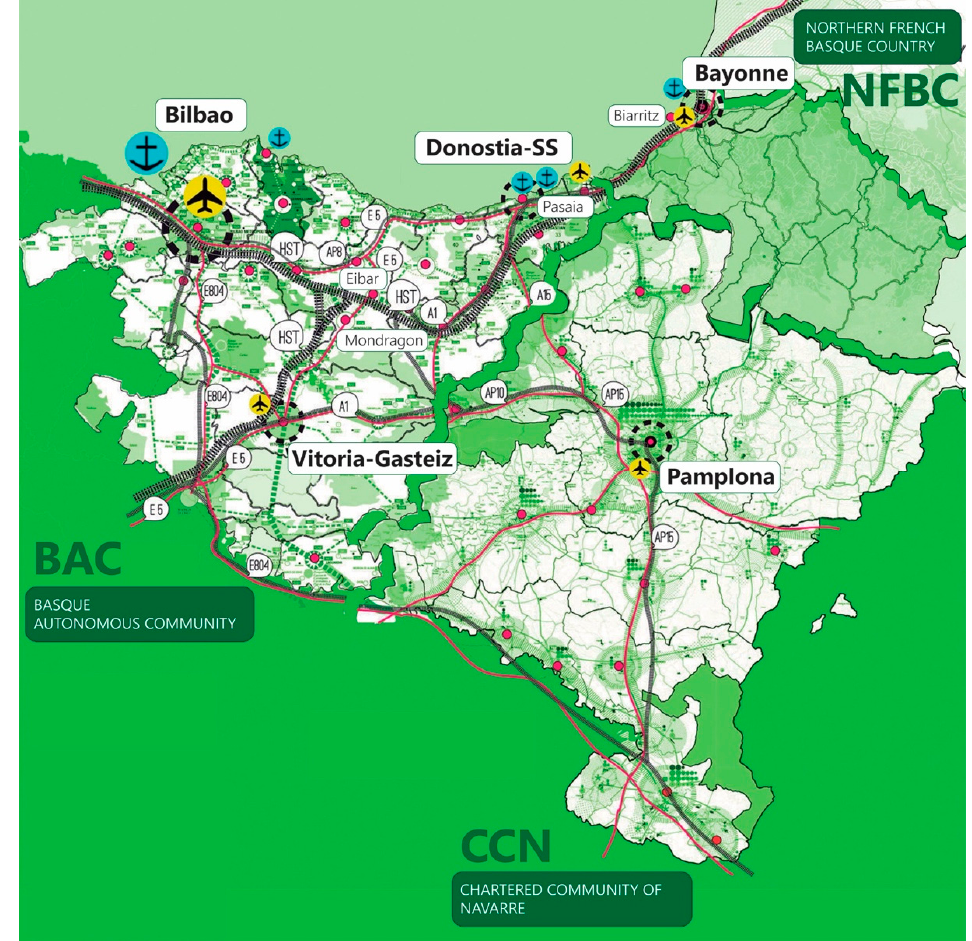
Figure 2. Continental Basque Country: Basque Autonomous Community (BAC) and Chartered Community of Navarre (CCN) in the Spanish Basque Country and Pays Basque commonwealth ( mancomunidad ) in the Northern French Basque Country (NFBC). (Source: Algorithmic Nations, Towards the Techno-Political Conceptual Assemblage [3]).